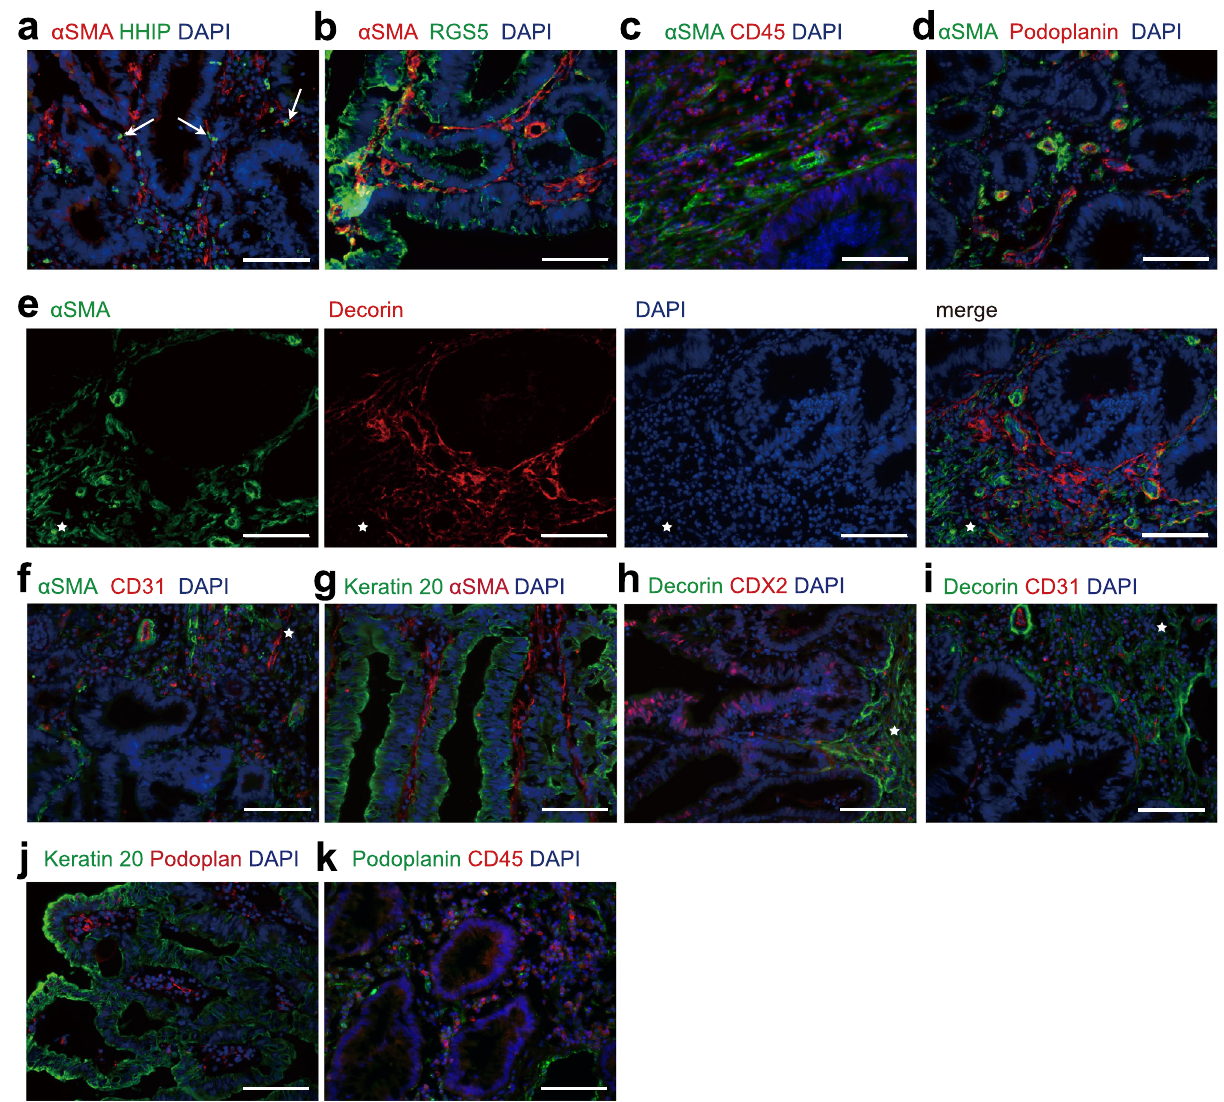
Fig. 6 Immuno fl uorescence staining of fi broblasts and myo fi broblasts in human colon cancer tissues. a HHIP + fi broblasts in CRC colon cancer tissues labeled with α SMA (red) and HHIP (green). Arrows point at the cells expressing both markers. Scale bar indicates 100 μ m. b Double labeling for α -SMA (red) and RGS5 (green) in colon cancer tissues. Scale bar indicates 100 μ m. c Double labeling for α -SMA (green) and CD45 (red) in colon cancer tissues. Scale bar indicates 100 μ m. d Double labeling for α -SMA (green) and Podoplanin (red) in colon cancer tissues. Scale bar indicates 100 μ m. e Double labeling for α -SMA (green) and Decorin (red) in colon cancer tissues. Each fl uorescent channel was displayed separately. f Double labeling for α -SMA (green) and CD31 (red) in colon cancer tissues. g Double labeling for Keratin 20 (green) and α -SMA (red) in colon cancer tissues. h Double labeling for Decorin (green) and CDX2 (red) in colon cancer tissues. i Double labeling for Decorin (green) and CD31 (red) in colon cancer tissues. a – e The star indicates submucosa adjacent to cancer cells. Scale bar indicates 100 μ m. j Double labeling for Keratin 20 (green) and Podoplanin (red) in colon cancer tissues. Scale bar indicates 200 μ m. k Double labeling for Podoplanin (green) and CD45 (red) in colon cancer tissues. Scale bar indicates 100 μ